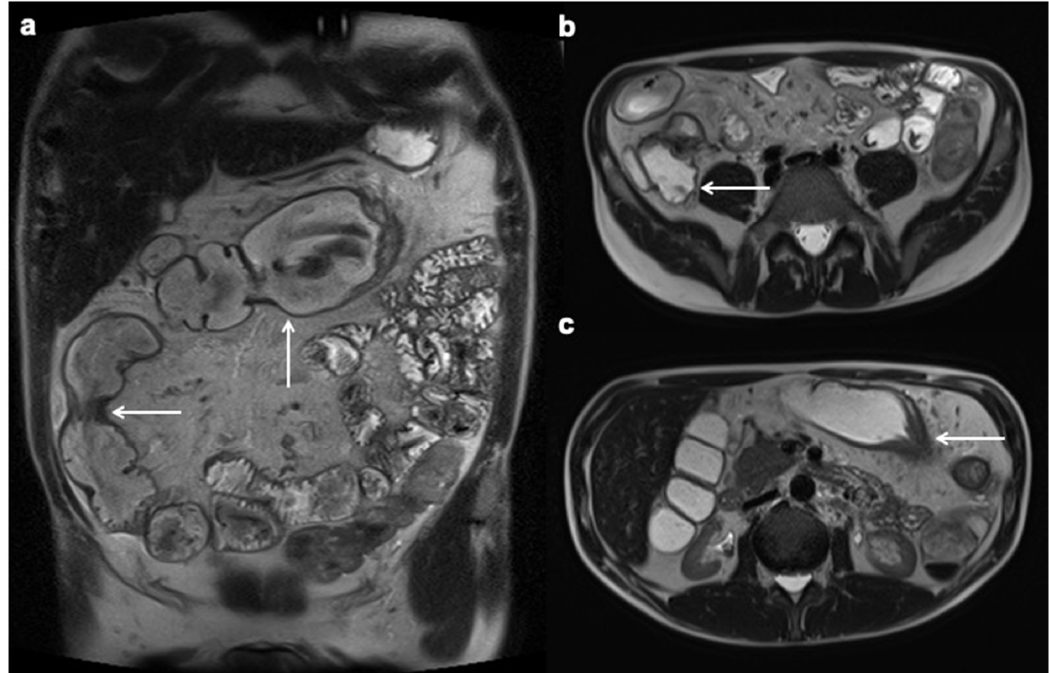
Figure 4. Stricture with upstream dilation (white arrows). Coronal ( a ) and axial ( b , c ) T2 FSE without FS MRE demonstrate ileal and transverse colon stricture with respectively mild (3–4 cm) and severe (>4 cm) upstream dilation.